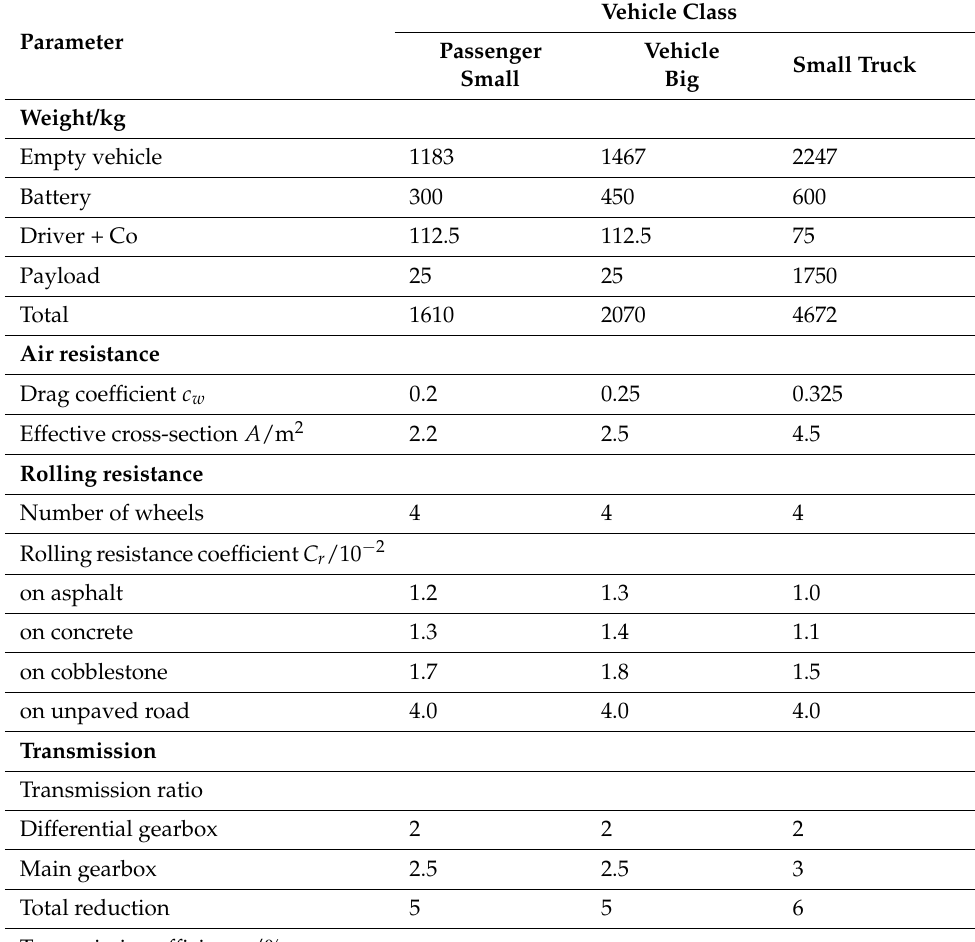
Table A1. Vehicle parameters used for state-of-the-art